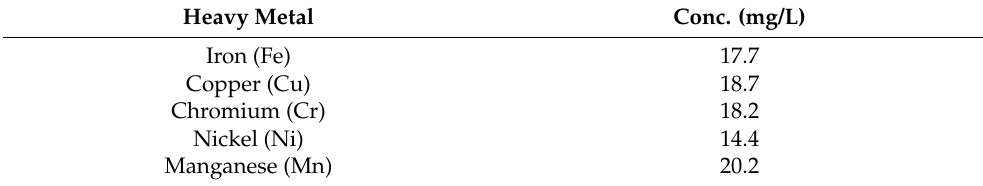
Table 2. Original concentrations of some heavy metals in the analyzed mixed